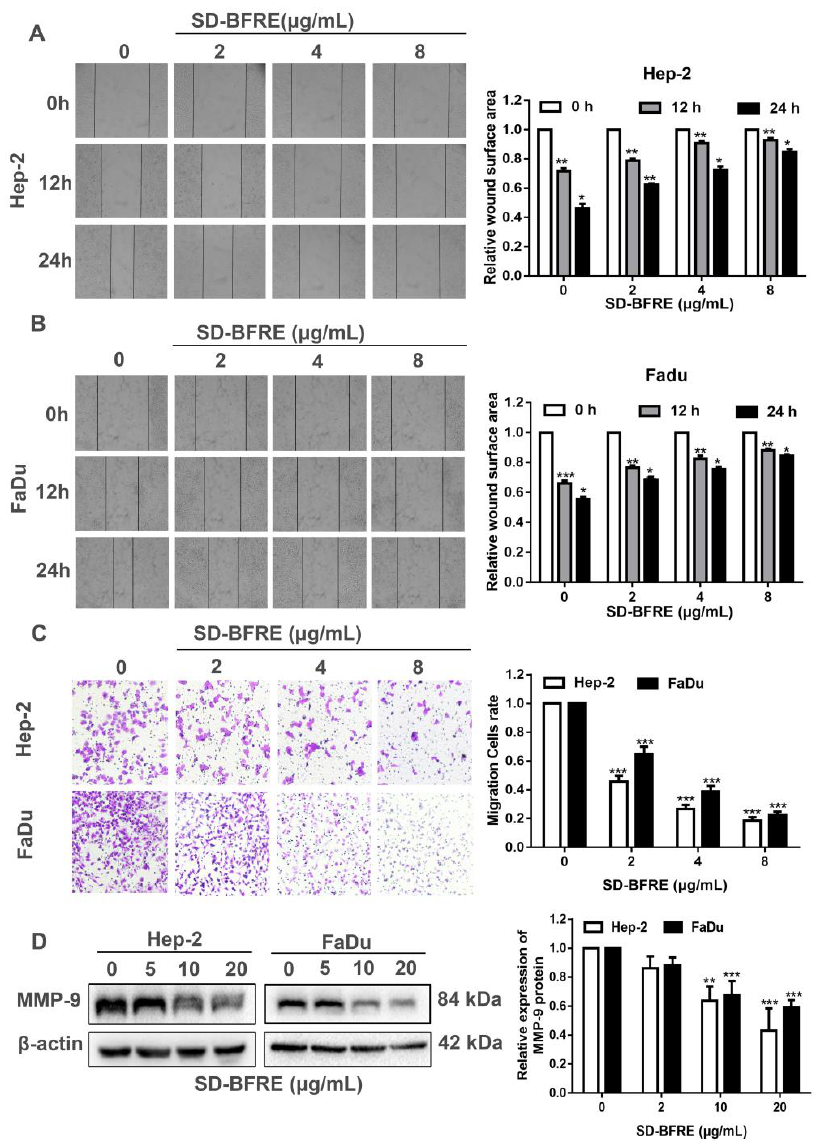
Figure 3. Effects of SD-BFRE on cell migration. ( A , B ) Micrographs of Hep-2 and FaDu cells after respective incubation with SD-BFRE (0, 2, 4 and 8 µ g/mL), and the wound surface area was counted by Image J software. ( C ) TC cells were seeded in Transwell chambers treated with SD-BFRE. The invading cells were calculated by a fluorescence microscope at the magnification of 200 × . ( D ) Effect of SD-BFRE on MMP-9 protein was performed by Western blot assay. β -actin was served as an internal reference (* p < 0.05, ** p < 0.01 or *** p < 0.001, compare to 0 μg/mL).